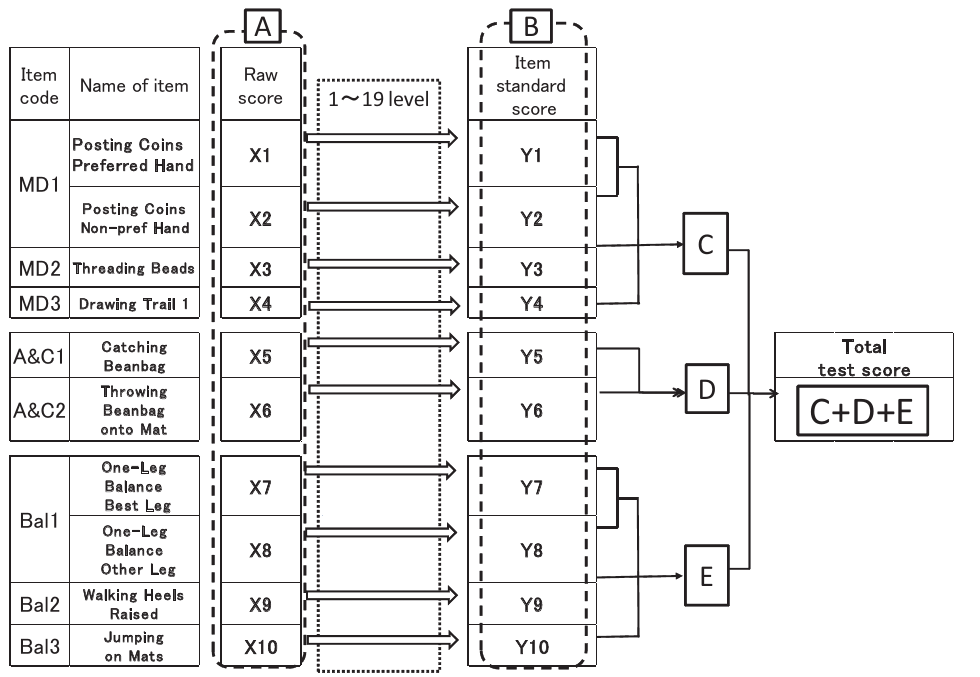
Figure 1. Scoring the motor component of the Movement Assessment Battery for Children—Second Edition